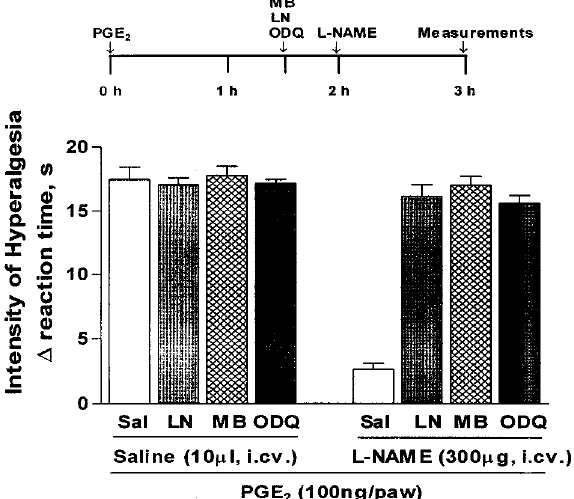
FIG. 6. Antinociceptive effect of intracerebroventricular administration of L-NAME (N G -nitro-L-arginine methyl ester) on PGE 2 -induced hyperalgesia, and its blockade by i.c.v. L-NMMA (LN, 300 m g,), MB (400 m g) or ODQ (8 m g). These drugs and vehicle were co-injected with L-NAME 2h after PGE 2 (100ng/paw). The intensity of hyperalgesia was meas- ured 1h after the i.c.v. injections. The bars are the mean, SEM of five rats/group. *,**mean significant differences ( P < 0.01) in comparison with the saline- (Sal) or L-NAME-treated group,